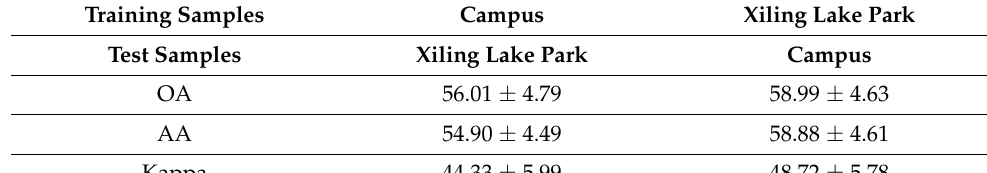
Table 4. Accuracy (%) of samples from the same region classifying samples from another region. Table 3. Accuracy (%) of single season samples classifying other season samples.